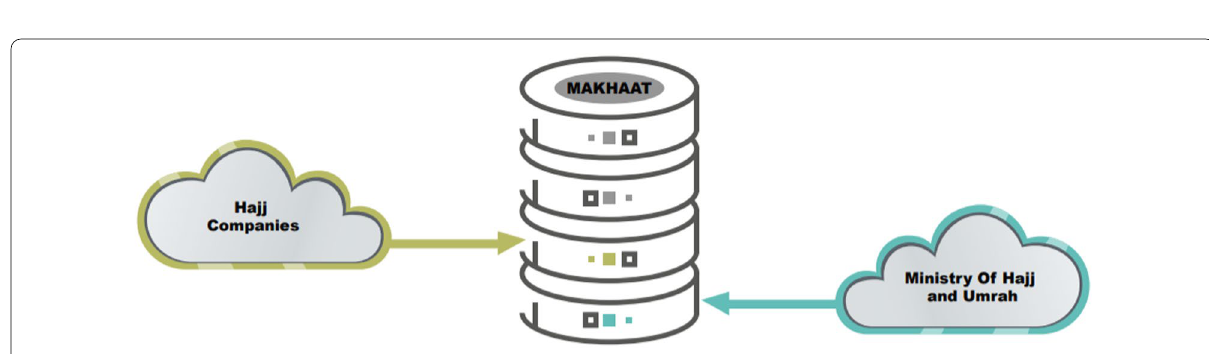
Fig. 6 Information transfer